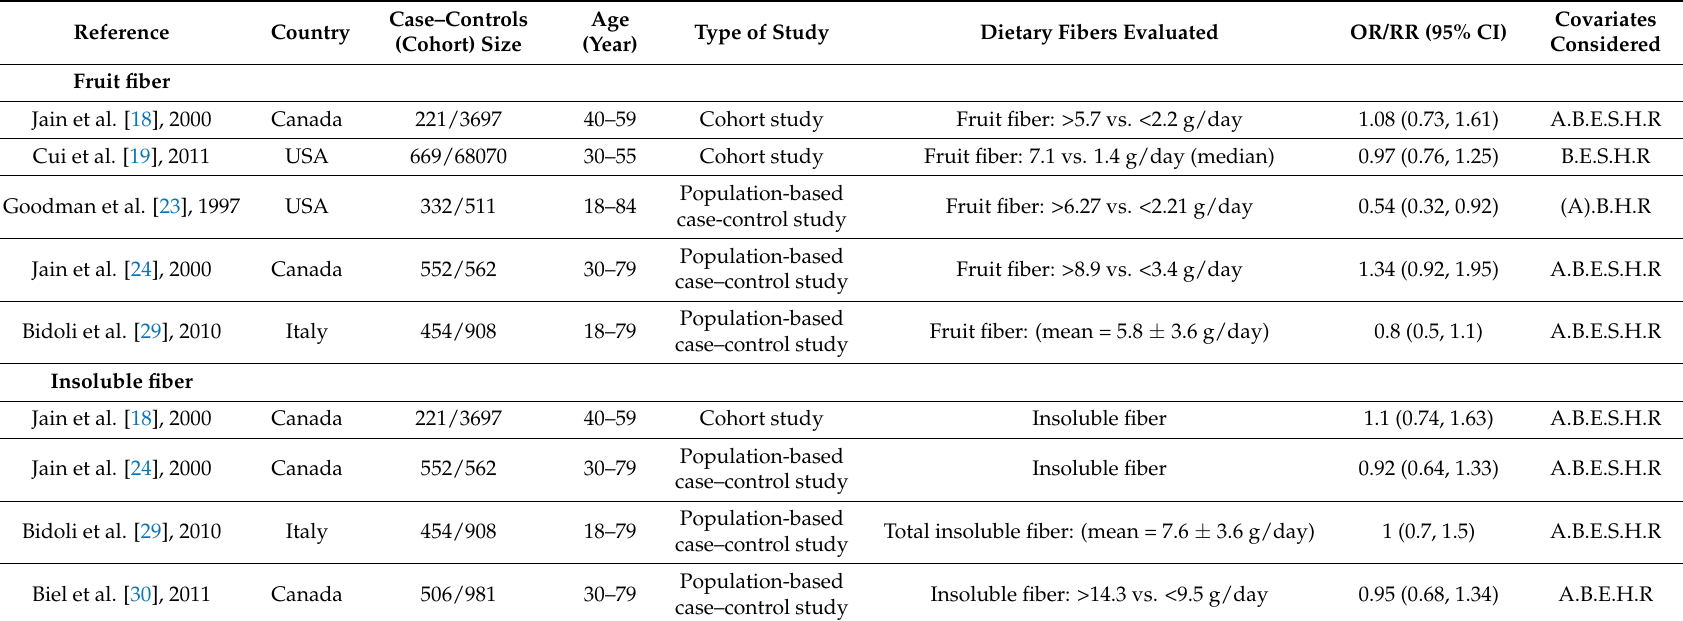
Table 2. Studies that evaluated fruit fiber and insoluble fiber with respect to endometrial cancer